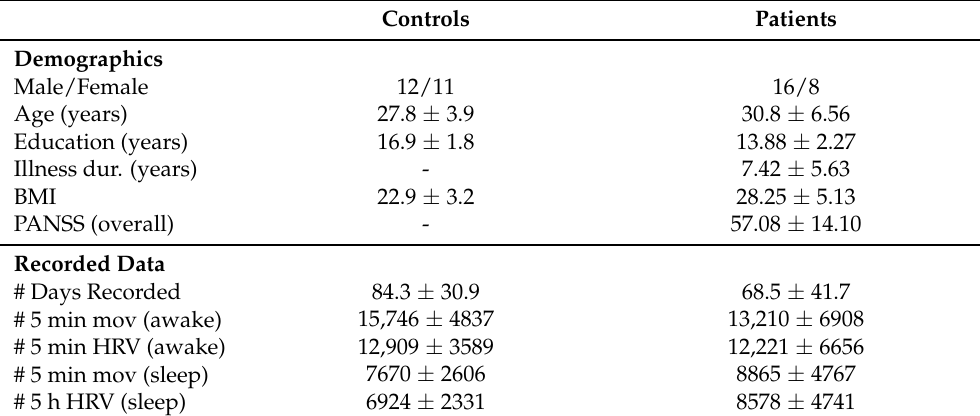
Table 3. Demographics information of controls and patients at the time of recruitment, illness information, and amount of recorded data for each group during wakefulness and sleep. There were no significant differences between the amounts of recorded data (tested with the Student’s t -test and Shapiro–Wilk for normality). Controls